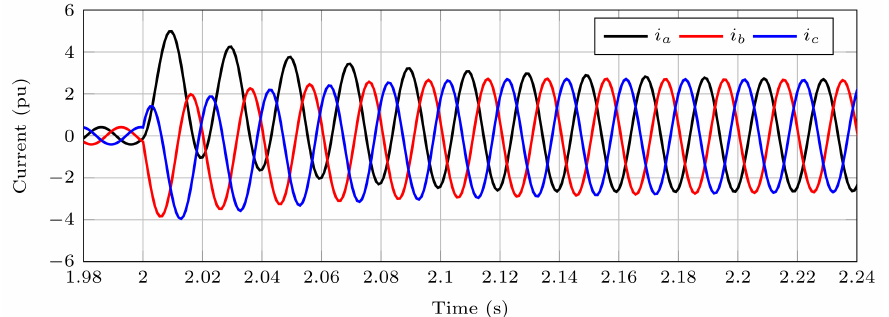
Figure 9. Short-circuit current response during the time period t = 0.98 s to t = 2.24 s of the LVRT event of Figure 6.